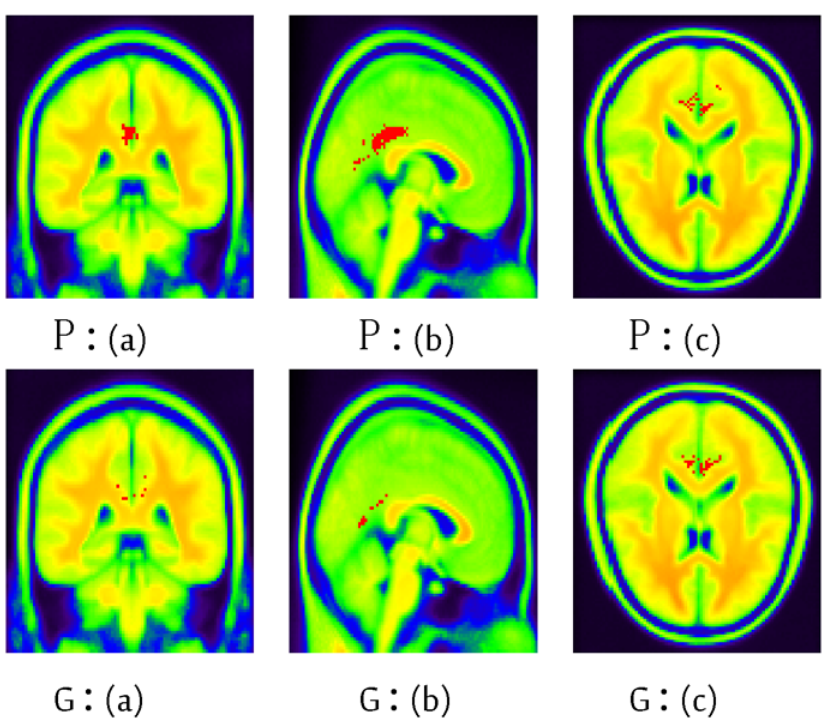
Fig 7. The informative regions (voxels) of MCI against AD using ADNI dataset of the 45th layer using BIC. (a): coronal view (b): sagittal view (c): transaxial view. P: primary sensorimotor cortex normalization; G: grand mean normalization. x , y and z are the width (91), depth (109) and height (91) respectively. The red points represent the informative voxels, whereas other colors are only used to depict the brain structure.